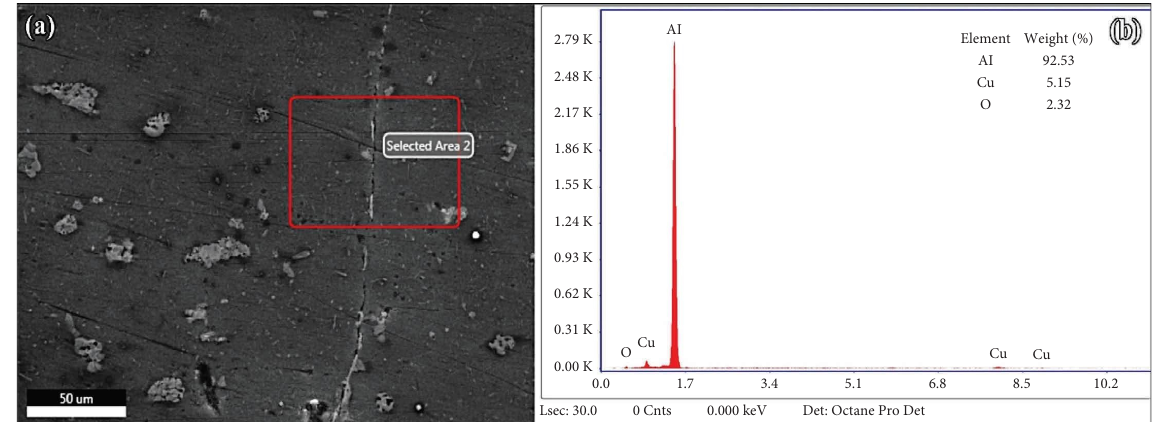
Figure 11: (a) EDS and (b) spectral analyses for the unbonded area on the interface at 475 °